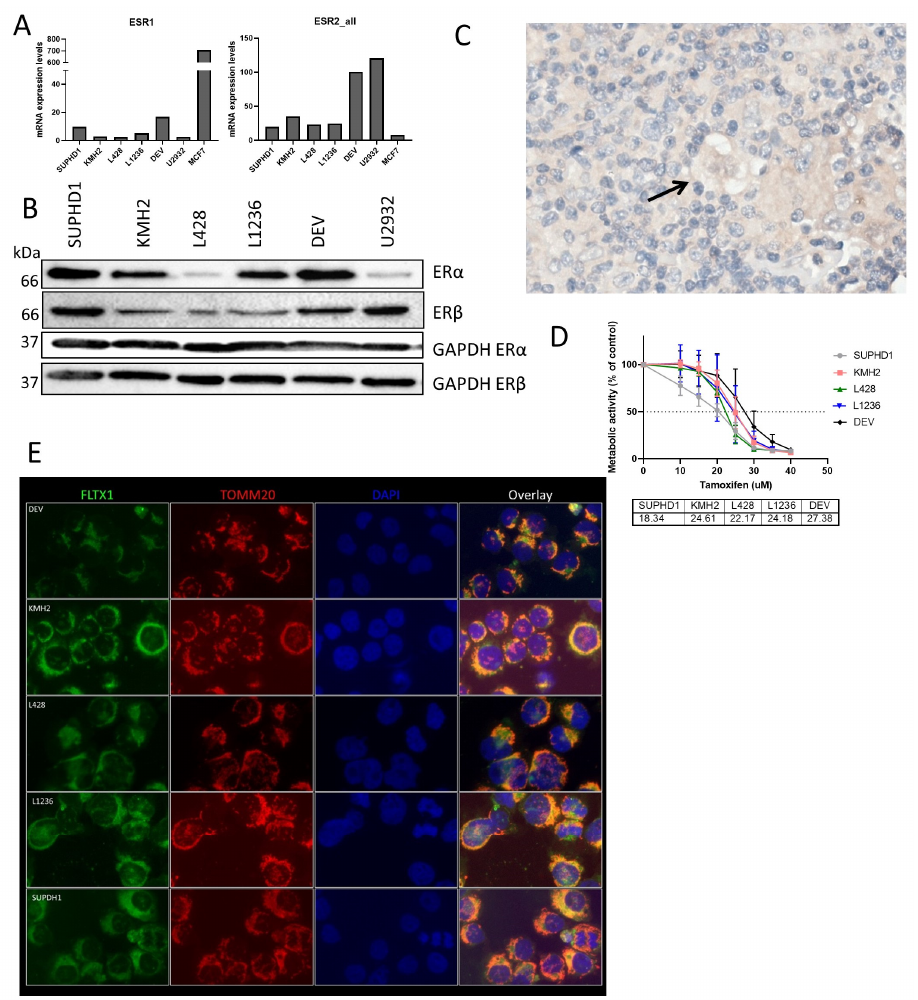
Figure 2. Estrogen receptor β expression in HL. ( A ). mRNA expression of ESR1 and ESR2 in HL cell lines. ( B ). Protein expression of ER α and ER β in HL cell lines by western blot. ( C ). Immunohistochemistry for ER β in a HRS cell in HL tissue. ( D ). Sensitivity for tamoxifen in HL cell lines. Sensitivity is measured by metabolic activity, IC50 values are given in µM. ( E ). Immunofluorescent staining of fluorescent labelled tamoxifen (FLTX1), mitochondria (TOMM20), nuclei (DAPI), and overlays on the 5 HL cell lines.